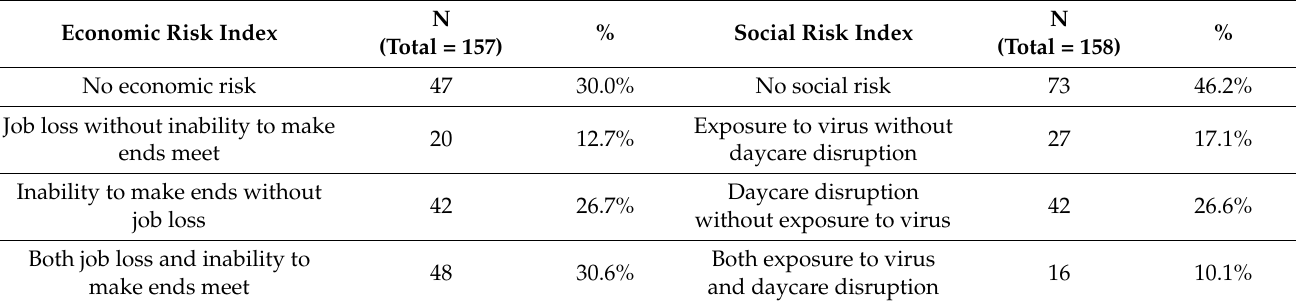
Table 2. Number and percent of individual parents encountering various economic and social